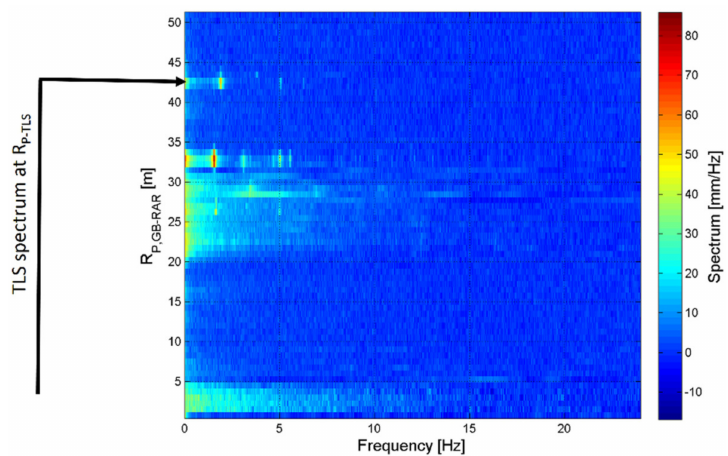
Figure 6. Sketch of proposed methodology to estimate vibration frequencies by the joint use of TLS and GB-RAR techniques.